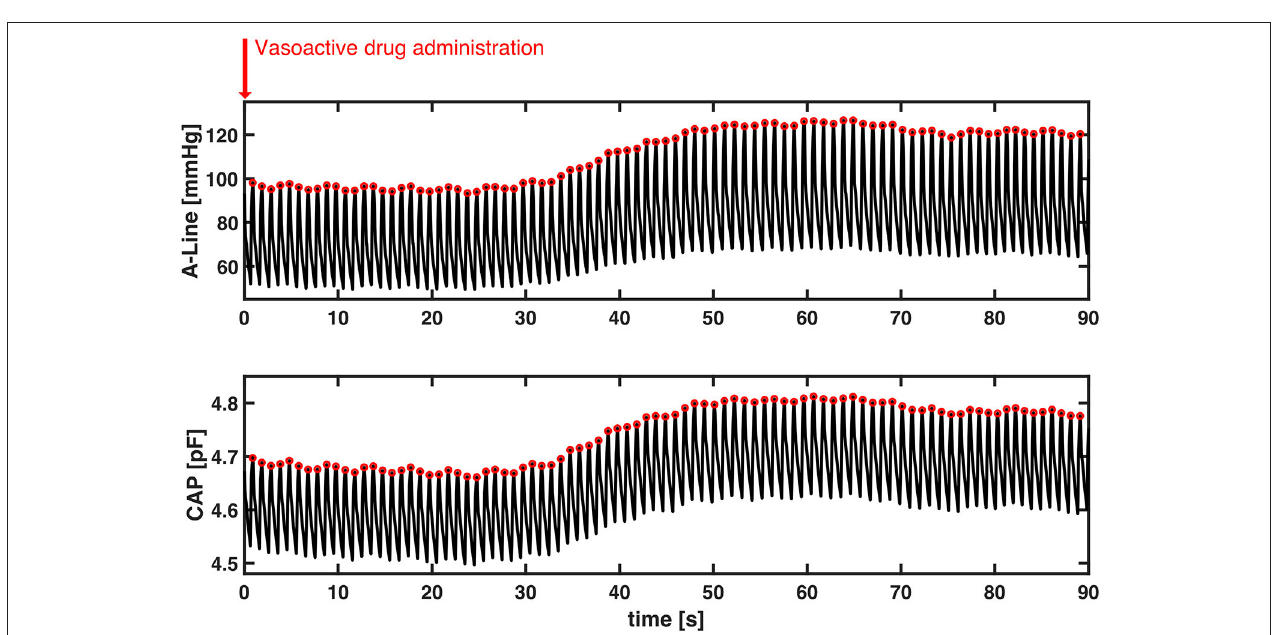
FIGURE 7 | A representative section of the temporal response to vasoactive drug administration in both A-Line and CAP signals. Without motion artifacts, BP increased about 30s simultaneously after Ephedrine and Vasopressin were administered. Systolic peak values of both A-Line and CAP signals were detected as the red circles. The Pearson correlation is